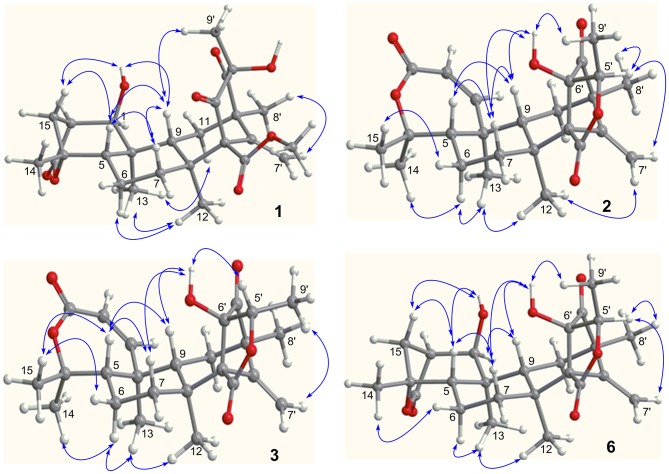
Key NOE correlations of 1–3 and 6. Arrow line means the NOE correlation from one proton to the other proton.